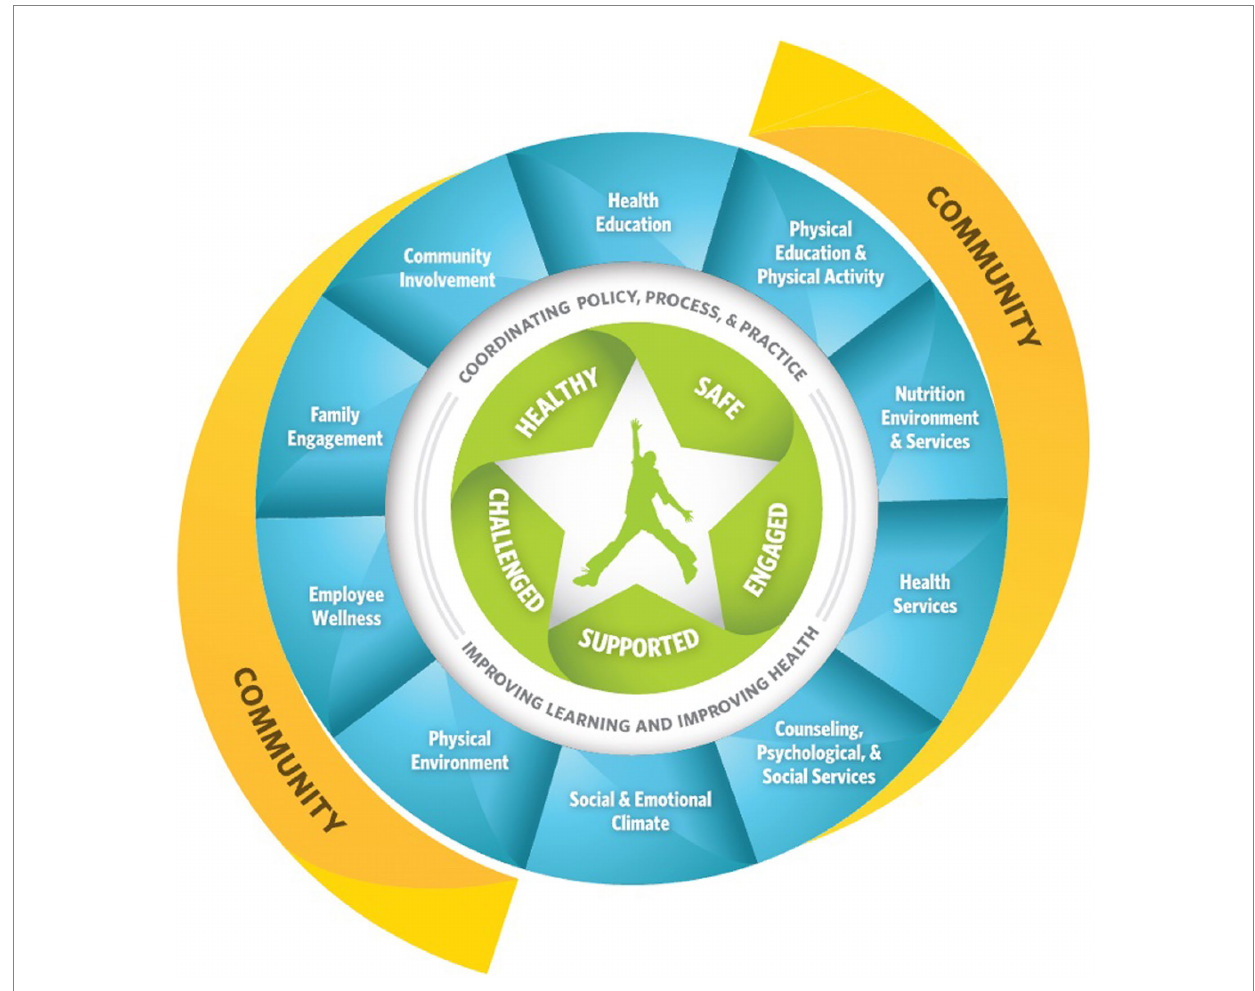
FIGURE 1 The whole school, whole community, whole child model. Available at: